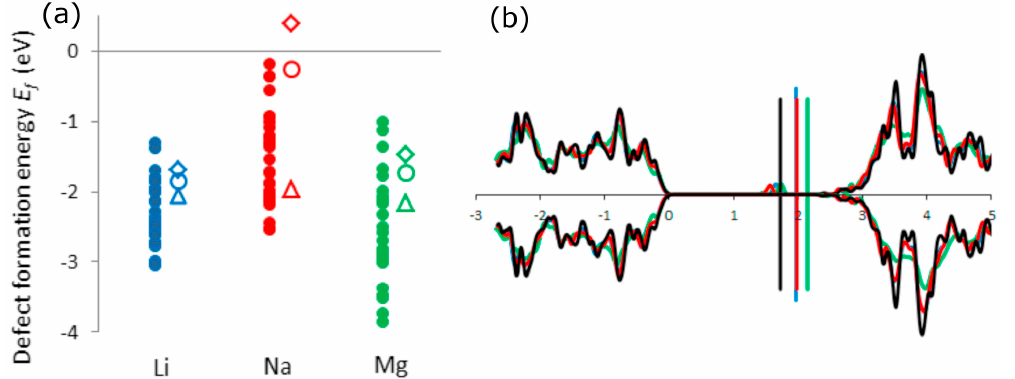
Figure 9. ( a ) Defect formation energies (having the same meaning as E b of Equation (1)) versus the bulk reference state for the insertion of Li (blue), Na (red), and Mg (green) in amorphous (full circle) and crystalline (empty circles, diamonds, and triangles designate anatase, rutile, and (B)TiO 2 , respectively) TiO 2 ; ( b ) Densities of states of Li (blue), Na (red), and Mg (green) doped as well as pure (black) anatase TiO 2 . The vertical lines represent the Fermi energies. Reprinted with permission from [22], © (2015) Elsevier.